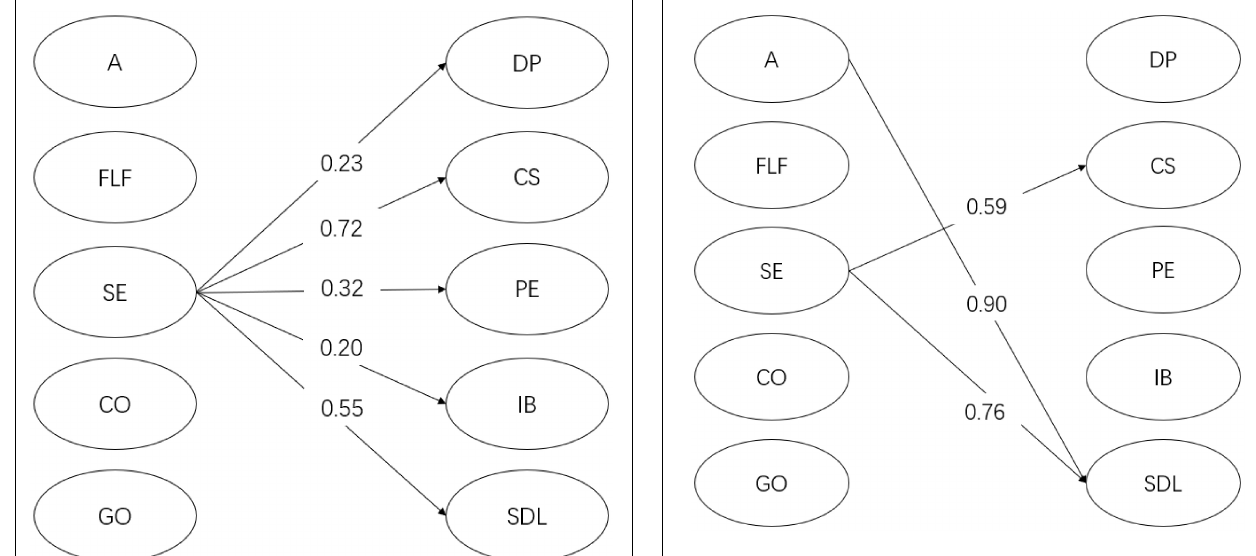
FIGURE 3 | The SEM model for year 2 students. Only significant relations are presented in the figure. DP, doing previews; CS, in-class communication self-efficacy; PE, positive experience of flipped classroom; IB, intentional behaviors; SDL, self-directed learning; A, autonomy; FLF, formative learning feedback; SE, English learning self-efficacy; CO, communication-oriented learning; GO, grammar/translation-oriented learning. of English learning self-efficacy in flipped English learning